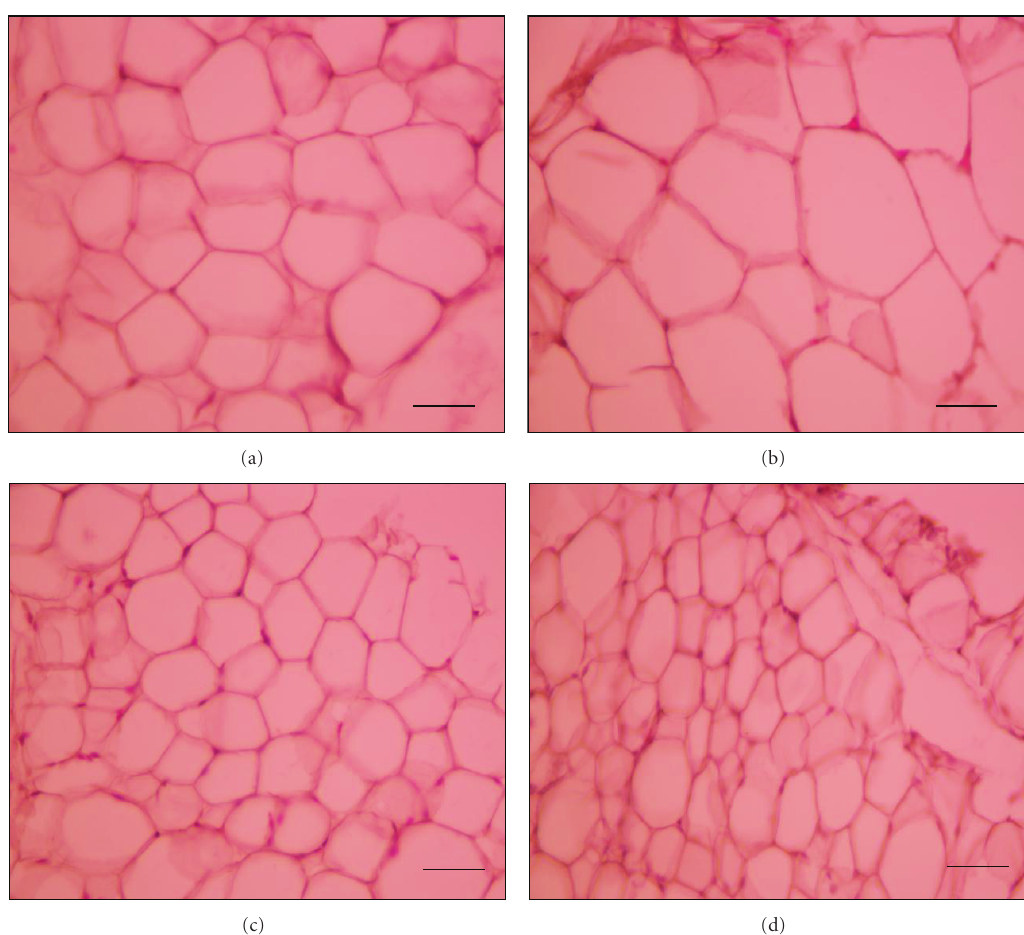
Figure 1: Representative fields of AAT from CD (a), FRD (b), CD-PIO (c), and FRD-PIO (d) rats stained with hematoxylin eosin (scale bar: 50 μ m; magnification: ×